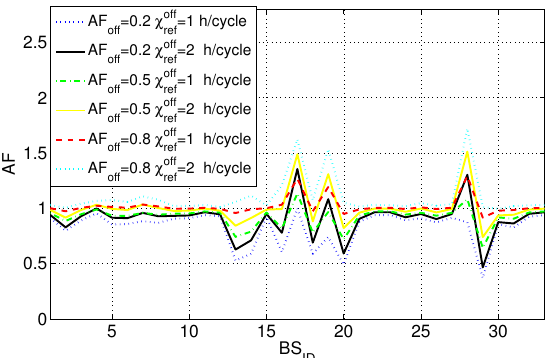
Figure 8. AF for the single BSs in the network (exponential